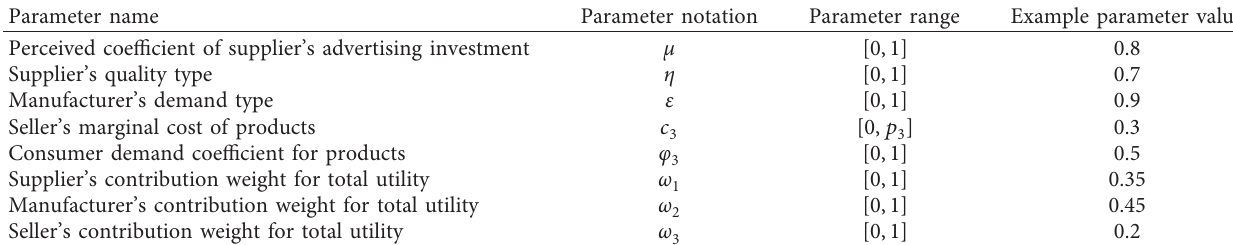
Table 2: Setting of relevant fixed parameters.